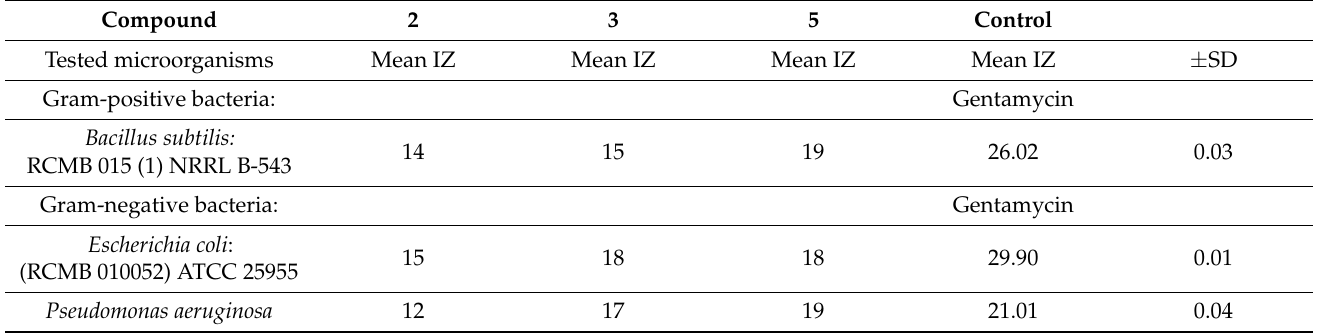
Table 3. Antibacterial activity of compounds 2 , 3 , and 5 against Gram (+) and Gram ( − ) bacteria. Mean zone of inhibition (IZ) in